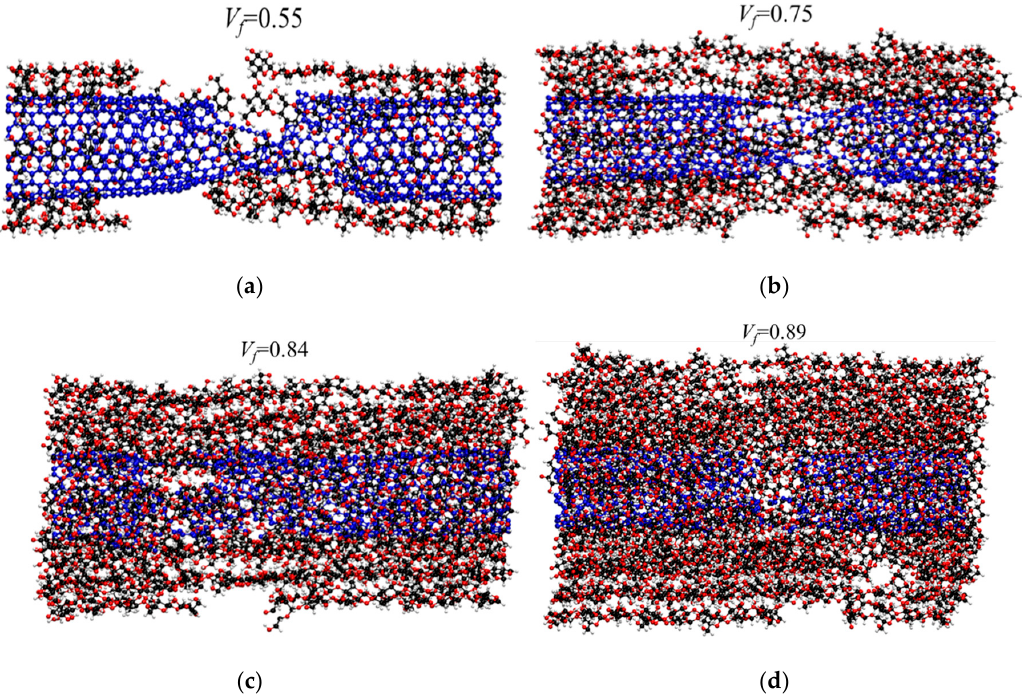
Figure 6. Fractured CNT-wrapped cellulose at different cellulose content and transition from more ductile fracture to more brittle by increasing cellulose content. ( a ) Ductile fracture of CNT at V f = 55%. ( b ) V f = 75% ( c ) V f = 84% and ( d ) Brittle fracture of CNT at V f =